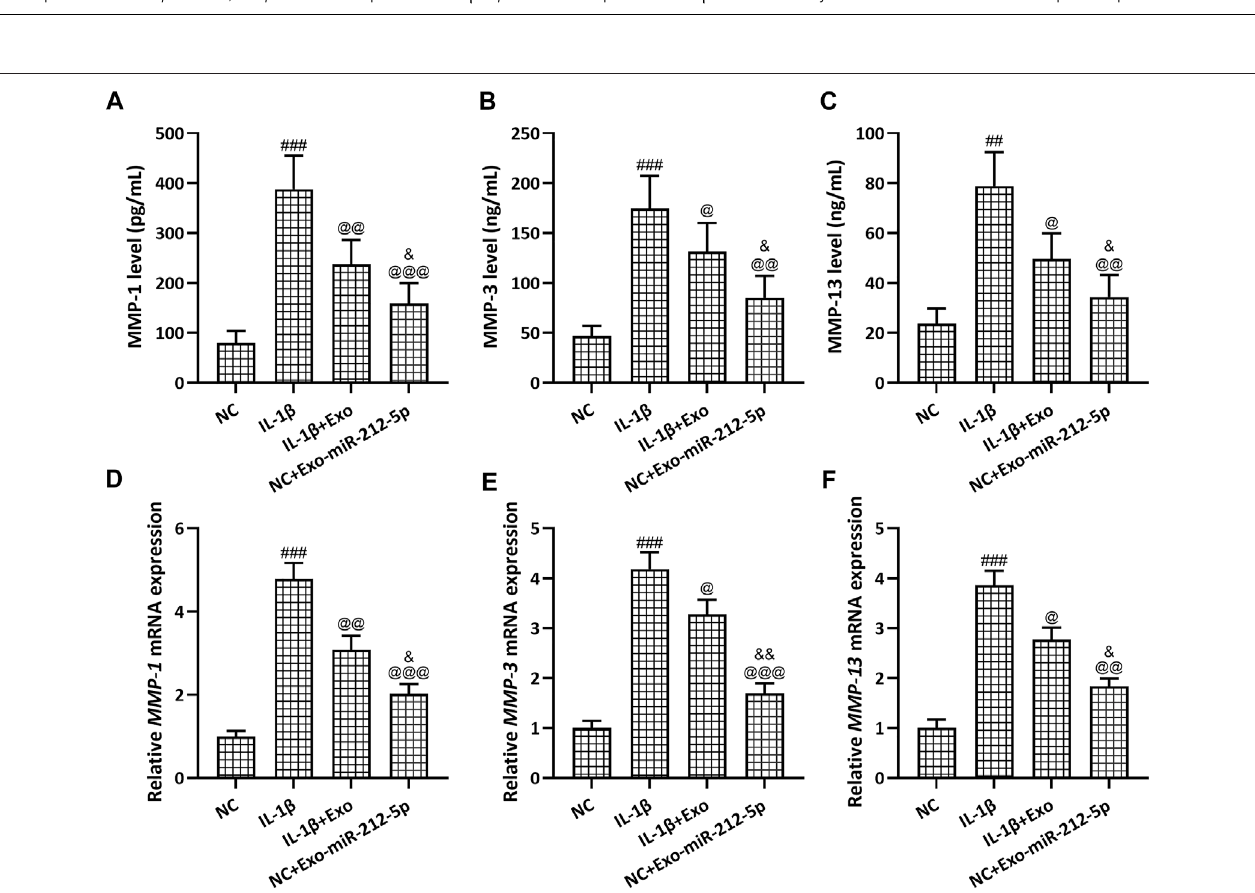
FIGURE 6| SMSC-212-5p-Exos attenuated IL-1 β induced MMP-1, MMP-3, and MMP-13 expression in chondrocytes. IL-1 β induced chondrocytes were treated withSMSC-Exos orSMSC-212-5p-Exosfor48 h.MMP-1, MMP-3,andMMP-13production incellular supernatant weremeasured byELISA (A – C) .mRNAexpression ofMMP-1,MMP-3,andMMP-13fromcelllysisweretestedbyqRT-PCR (D – F) . n =6foreachgroupinELISAanalysis, n =3foreachgroupinqRT-PCRtest.## p < 0.01, ### p < 0.001 compared to NC. @ p < 0.05, @@ p < 0.01, @@@ p < 0.001 compared to IL-1 β . & p < 0.05, && p < 0.01 compared to IL-1 β +Exo. One-way ANOVA followed Dunn ’ s multiple comparisons